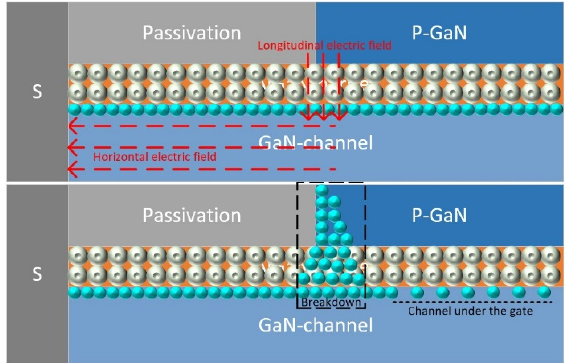
Figure 12. Thermal damage mechanism description of the hot spot. Figure 13 shows the electron current distribution near the source at the different mo- ments extracted from the simulation software which fit the above hypothesis well. Before the breakdown, electrons are concentrated in the two-dimensional electron gas layer, where the temperature gradually rises. With the accumulation of heat, the internal energy of electrons and atoms continues to increase, and the probability of breakdown occurring increases with time, and finally reaches the breakdown threshold, forming a large break- down current across the channel, AlGaN-barrier, and p-GaN region. As shown in Figure 13b, the breakdown zone shares most of the current in the channel region under the gate and makes the channel almost off. The reaction of the breakdown current and resistance in this area generates a large amount of Joule heat, which causes the temperature of the HEMT device to increase until it burns out.